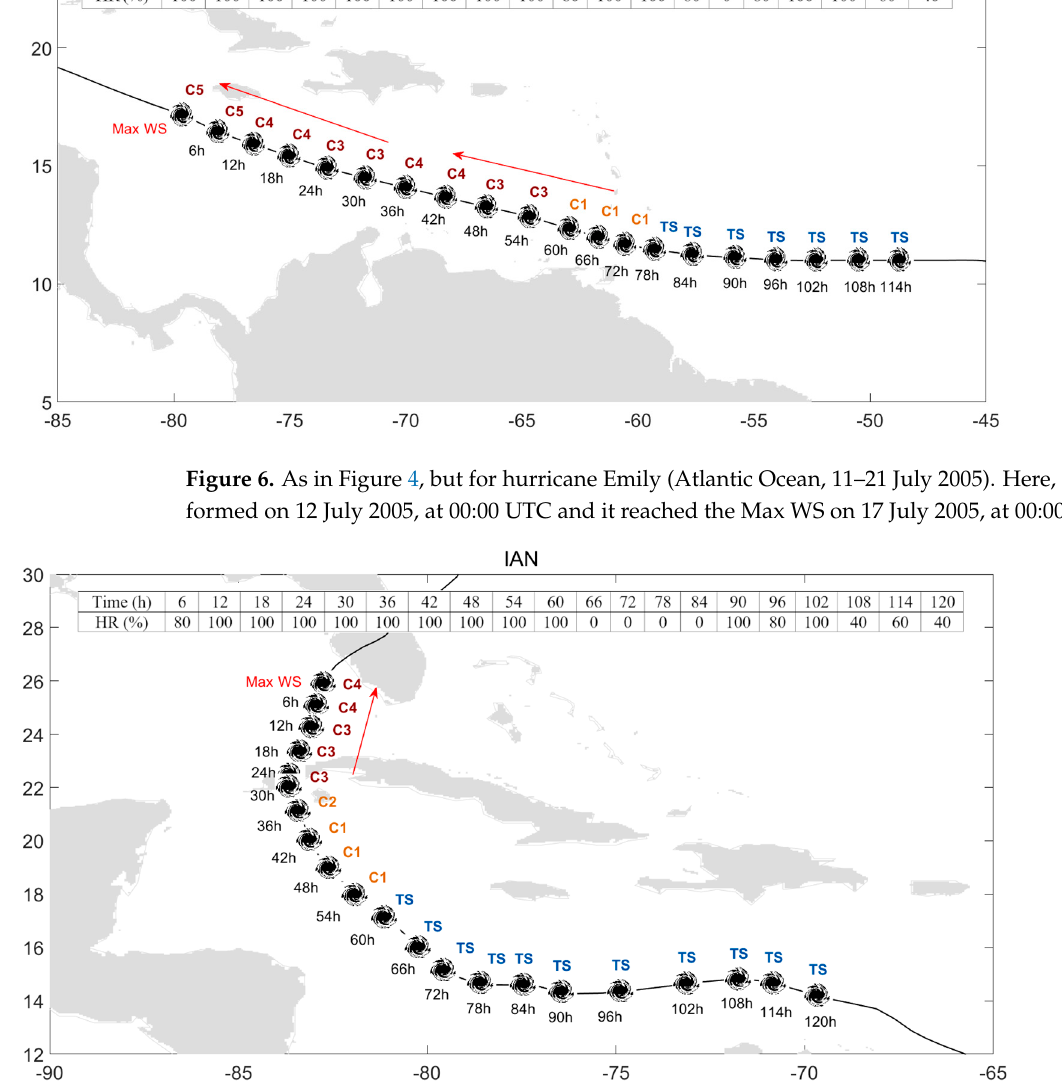
Figure 7. As in Figure 4, but for hurricane Ian (NE Atlantic Ocean, 19 September–2 October 2022). Here, the TS was formed on 19 September 2022, at 12:00 UTC and it reached the Max WS on 28 September 2022, at 12:00 UTC.